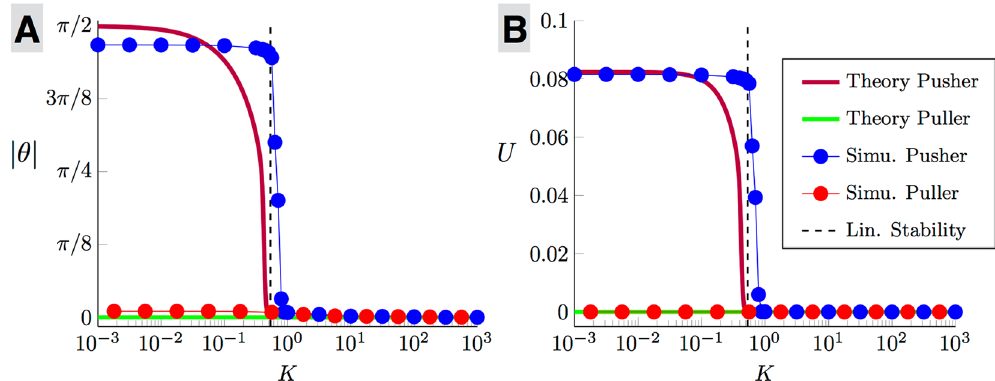
Figure 4. Steady-state flagella tilt angles (| θ |, A ) and lab-frame swimming speeds ( U , B ) for the full computational model of Fig. 2A with two flagella (symbols and thin lines) and for the simple active filament model of Fig. 2B (thick lines) as a function of the dimensionless hook spring constant, K . Green line and light red symbols: puller bacterium for which the non-swimming state is always stable; Dark red line and dark blue symbols: pusher bacterium which undergoes a transition to swimming for K < K c . The dashed line shows the critical spring constant predicted theoretically, K c ≈